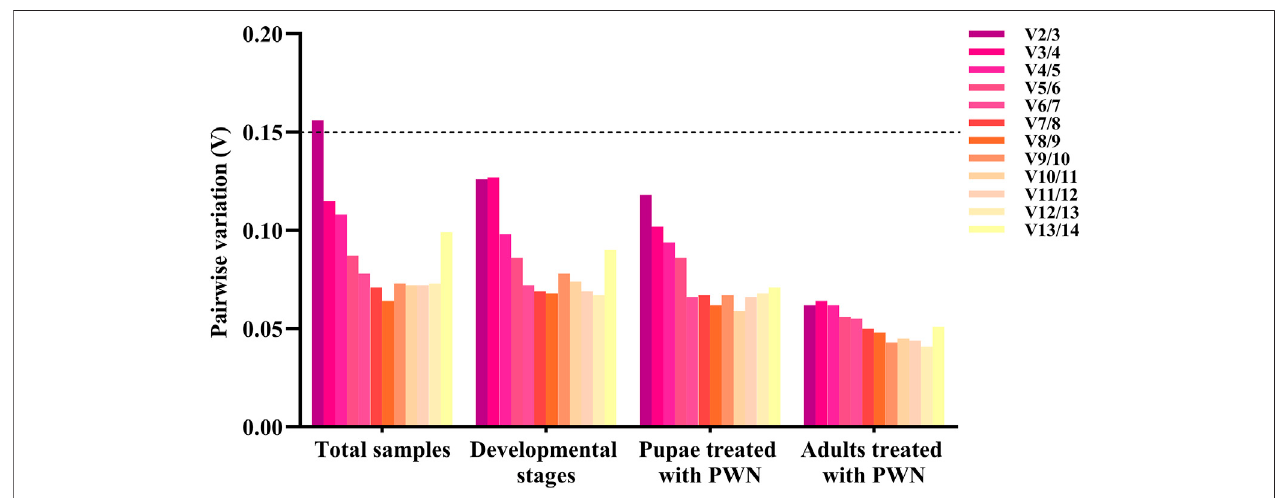
FIGURE 3 | Pairwise variation (V) of 14 reference genes in different conditions calculated by geNorm. The threshold value for assessing the optimal number of reference genes for RT-qPCR normalization is 0.15.